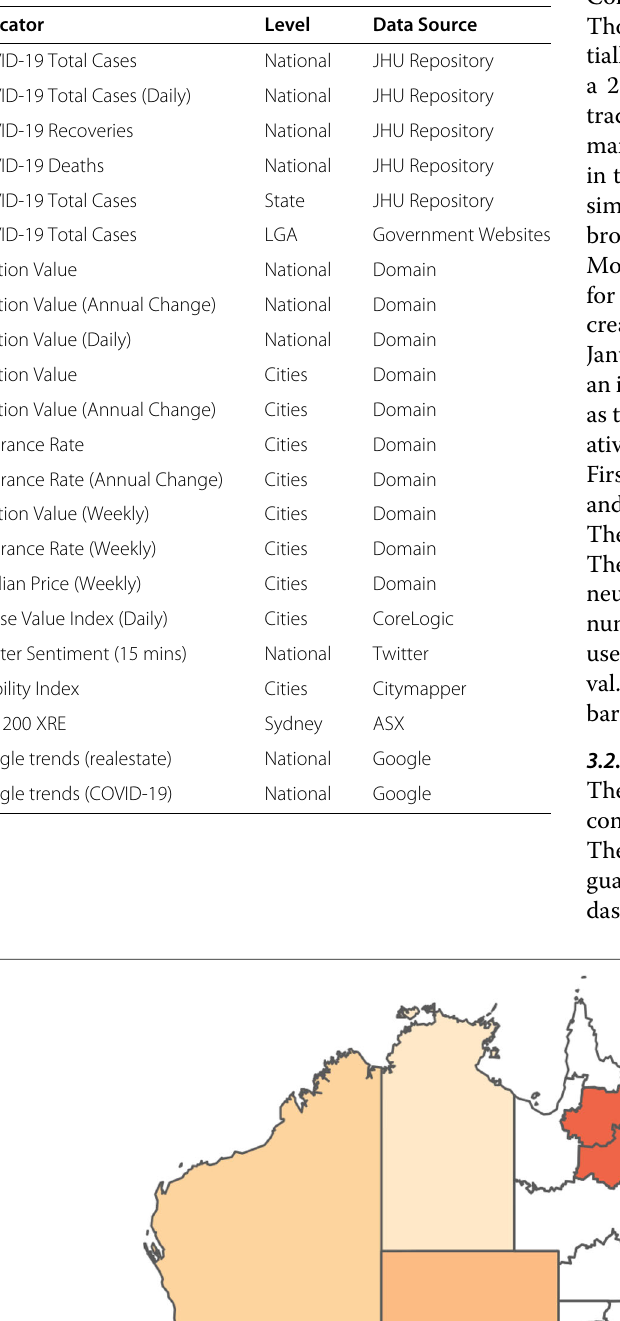
Table 2 Indicators, Data Sources and Processing of the Data